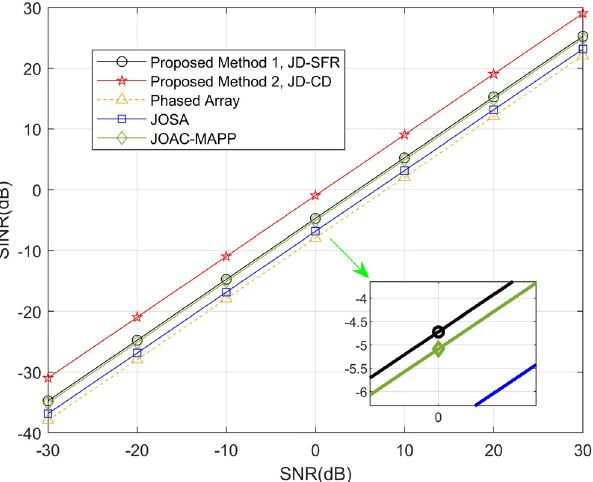
Figure 7. Comparison of obtained SINR using the proposed methods and other methods for ◦ . ∆ θ min = 25